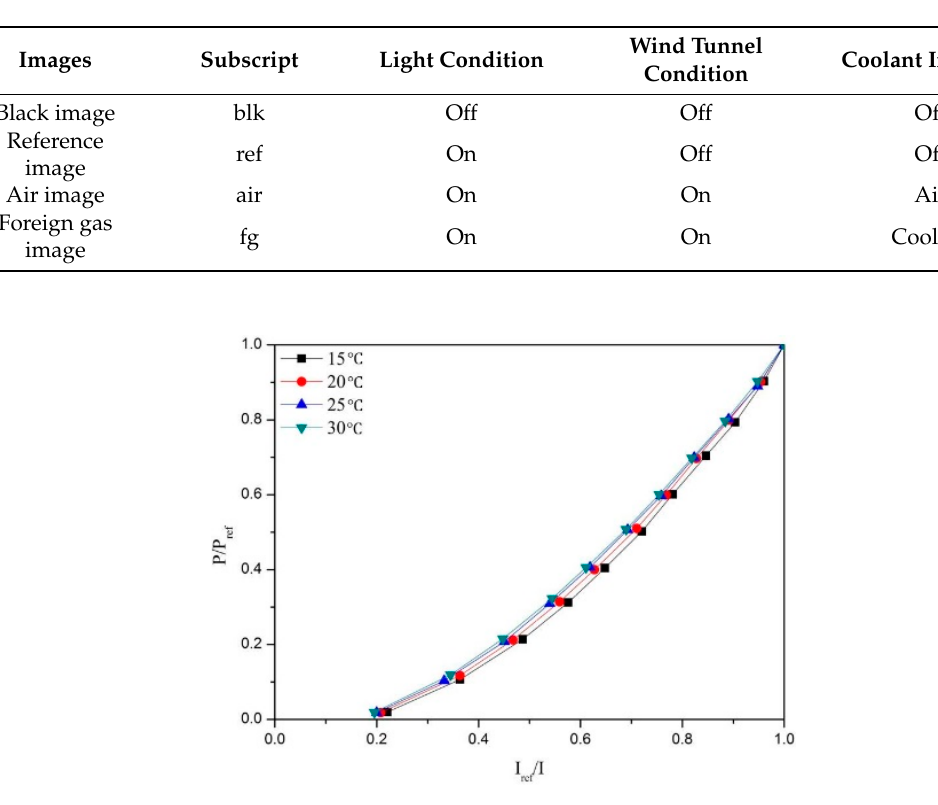
Figure 2. Waveforms of the input voltage and current (6 kV input voltage case).